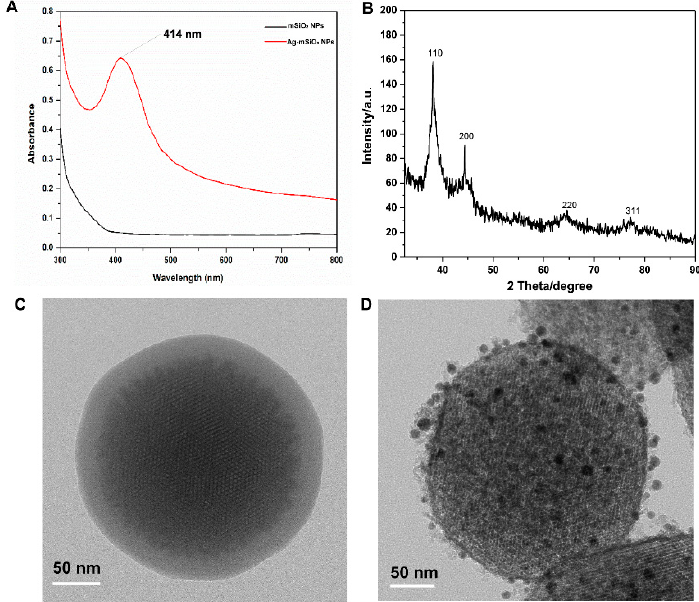
Figure 2. Characterization of mSiO 2 NPs and Ag-mSiO 2 NPs. ( A ) UV-vis-NIR absorption spectrum. ( B ) Wide-angle XRD patterns. ( C ) High-resolution transmission electron microscopy (HRTEM) of mSiO 2 NPs. ( D ) HRTEM of Ag-mSiO 2 NPs .